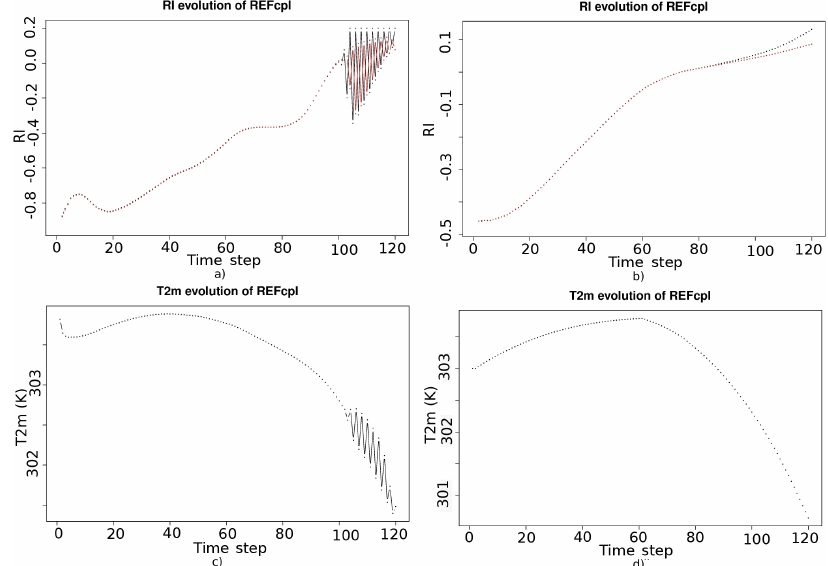
Figure 3. Evolution of the Richardson number ( RI , top) and T 2m (bottom) during a 6h coupled run for 2 July 2010 from 12:00 until 18:00UTC at location B (left) and location C (right). In the top figures, the Richardson number for the lowest level is shown as it is calculated in SURFEX (black) and as it would be calculated in ALARO (red).